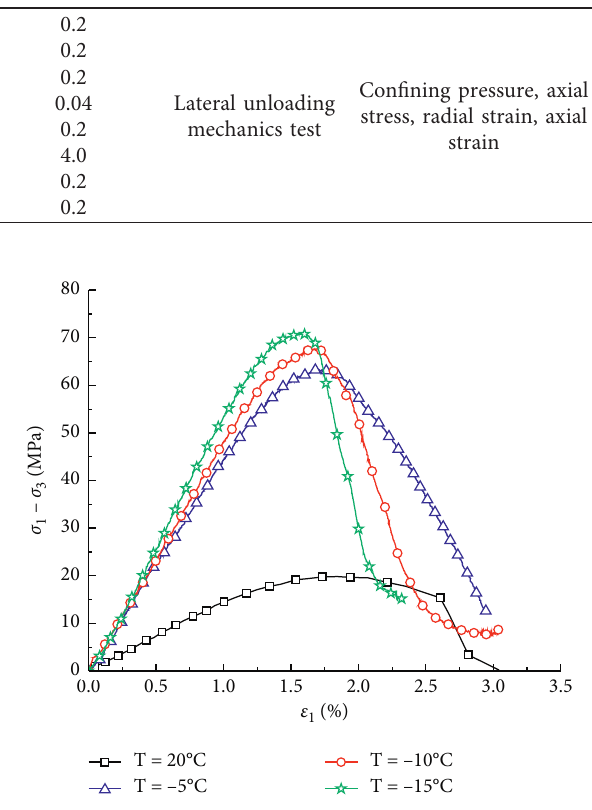
Figure 5: Stress-strain curve of sandstone at different temperatures � ( σ 3